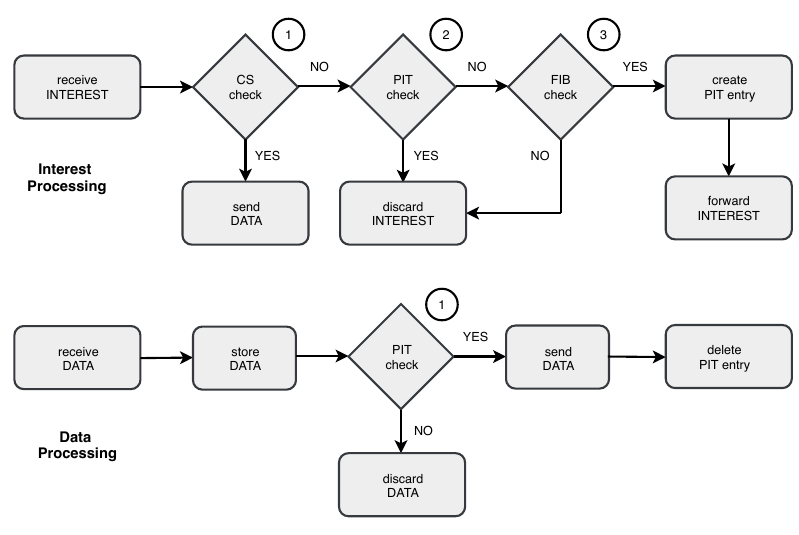
Figure 1. Message processing and forwarding in Content-Centric Networking